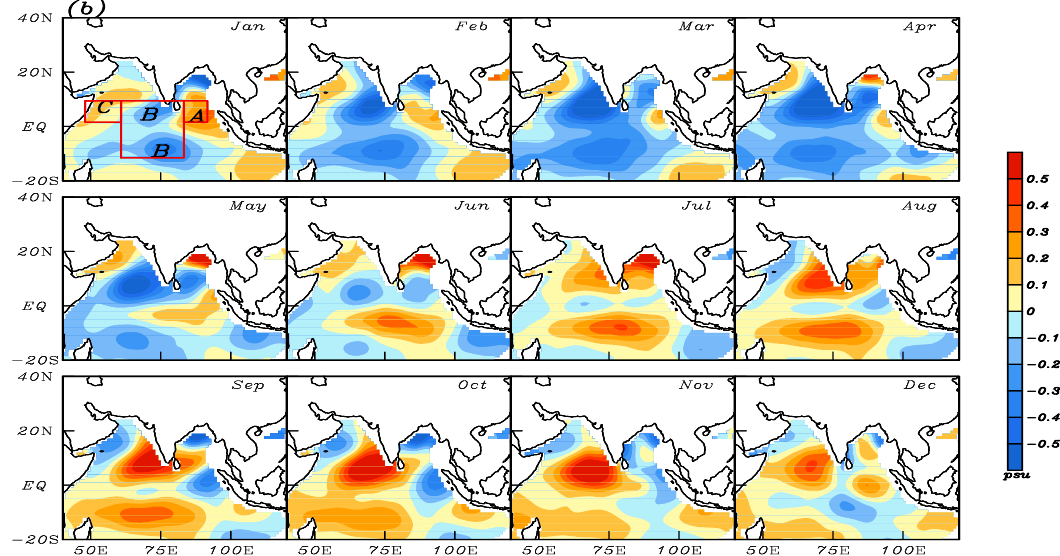
Figure 1. Seasonal variability of sea surface salinity in the Indian Ocean. The annual cycle of sea surface salinity anomalies by ( a ) Aquarius dataset during 2012 – 2014 and ( b ) Argo dataset during 2005 – 2014. A, B and C (see January) denotes the eastern part (A EIO ), the central part (B CIO ) and the western part (C WIO ) of the Indian Ocean respectively.